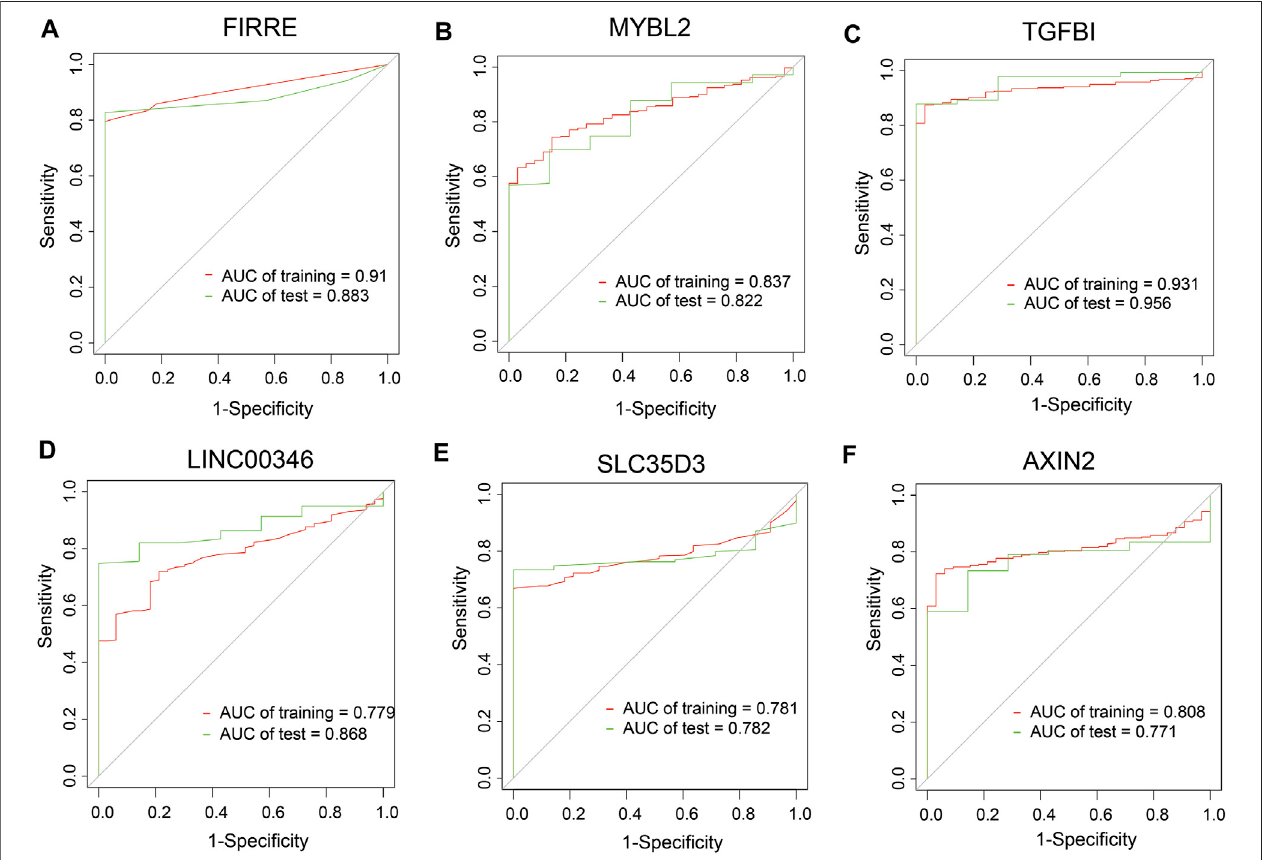
FIGURE 6 | Clinical performance assessment of preliminary shortlisted genes. (A – F) ROC curves of single genes, including FIRRE, MYBL2, TGFBI, LINC00346, SLC35D3, and AXIN2. AUC values are greater than 0.7.